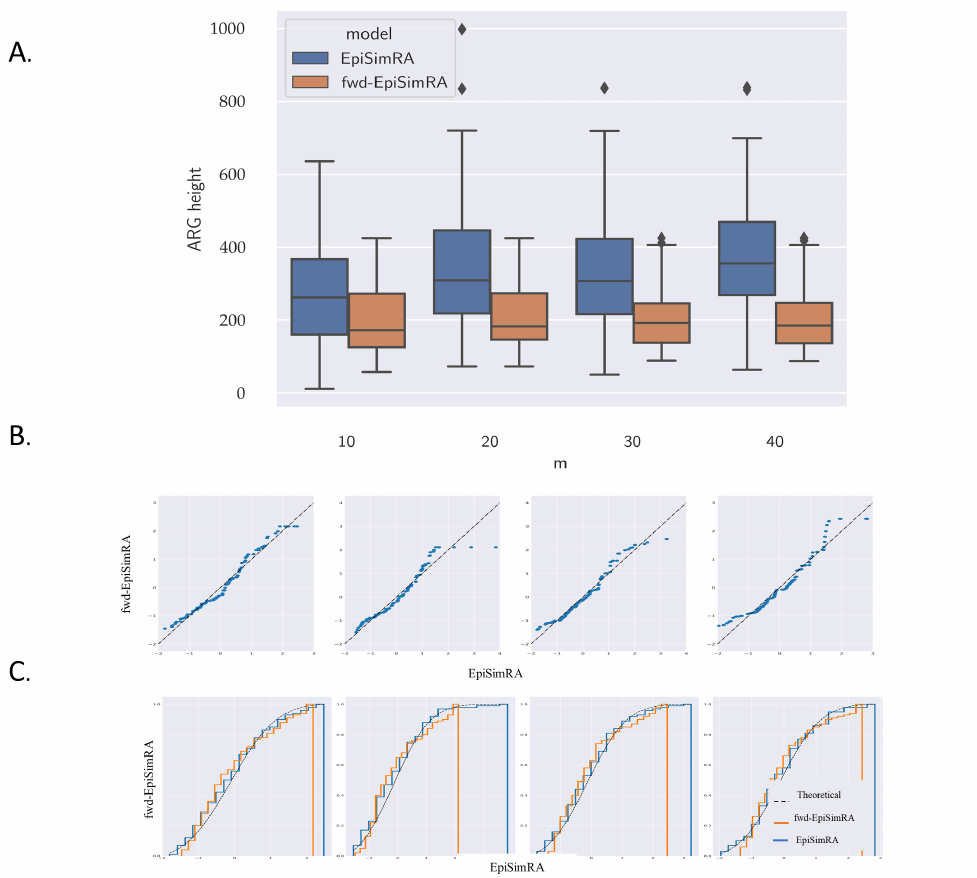
Figure A4. Comparing the height of the ARG (H) between fwd-EpiSimRA and EpiSimRA for selection in single locus with recombination for N = 100, g = 250 kbp, r = 1.0 × 10 − 8 , m = { 10.20,30,40 } , s = 0.3. ( A ) The box-and-whisker diagram summarizes the result for each. On each box, the central mark is the mean, the edges of the box are the 25th and 75th percentiles, the whiskers extend to the most extreme data points not considered outliers, and outliers are plotted individually. ( B ) QQ plot and ( C ) CDF plot of the backward and forward models show similar distributions.